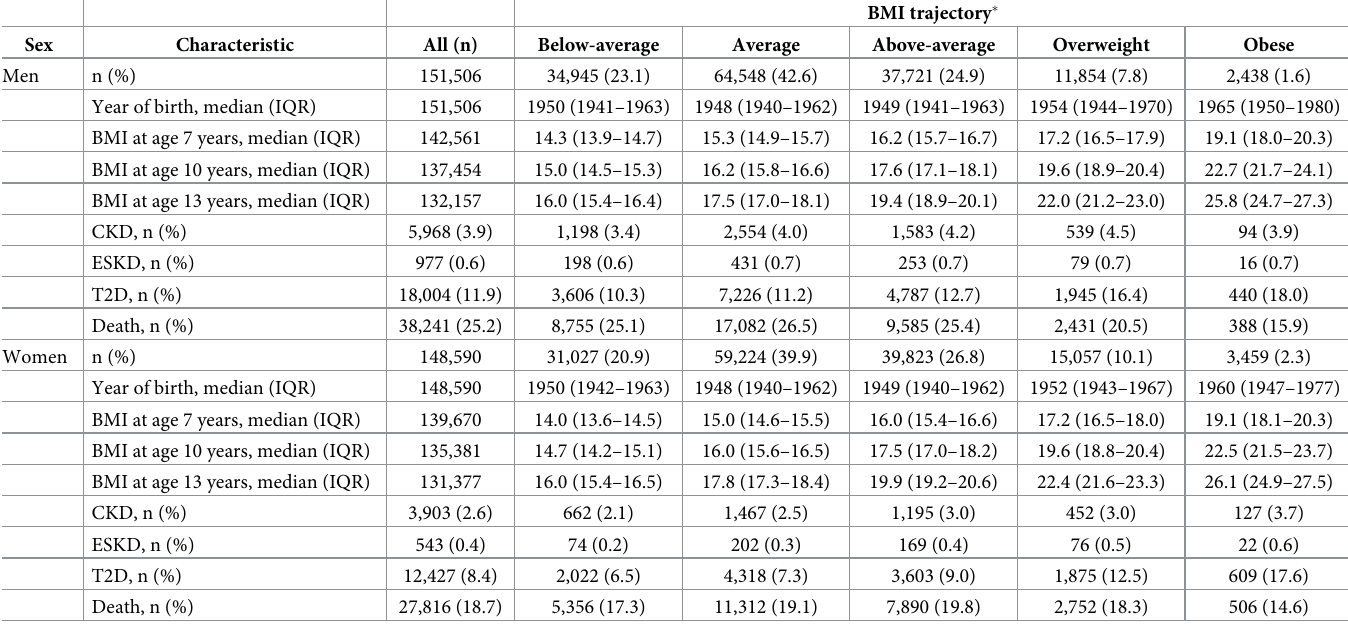
Table 1. Characteristics of individuals in the CSHRR by childhood BMI trajectory and by